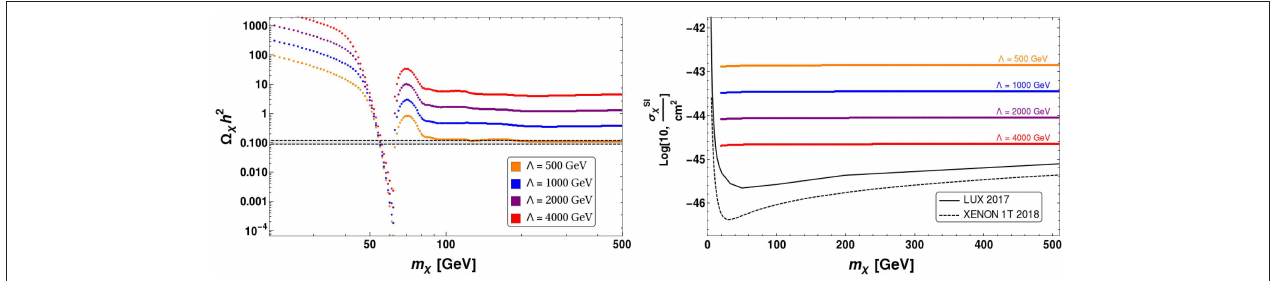
FIGURE 1 | (Left) Relic density as a function of singlet DM mass, m χ for different values of 3 mentioned in the figure inset. (Right) SI DD cross-section vs. DM mass, m χ for different values of 3